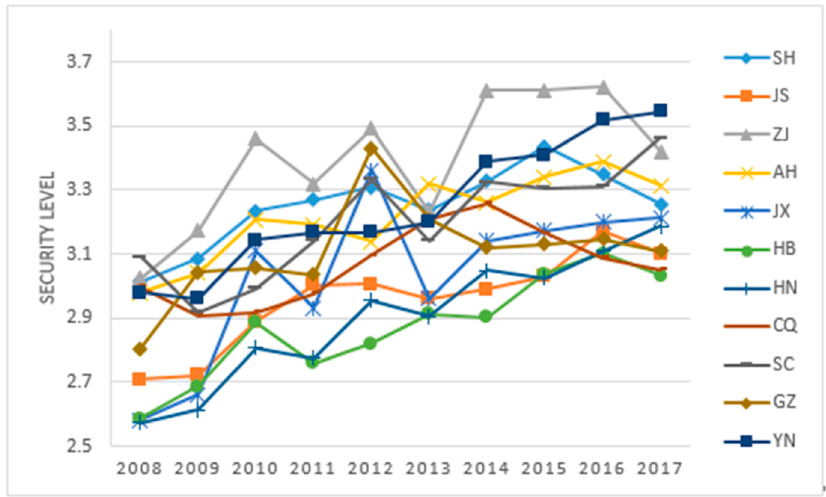
Figure 4. Trend graph of W-E-F security of each province (municipality) in the Yangtze River Eco-